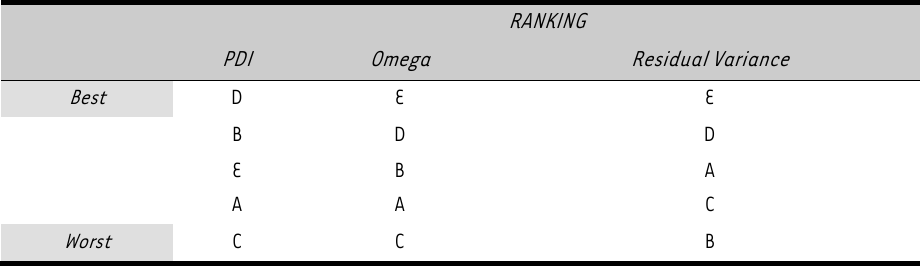
Source: Compiled by